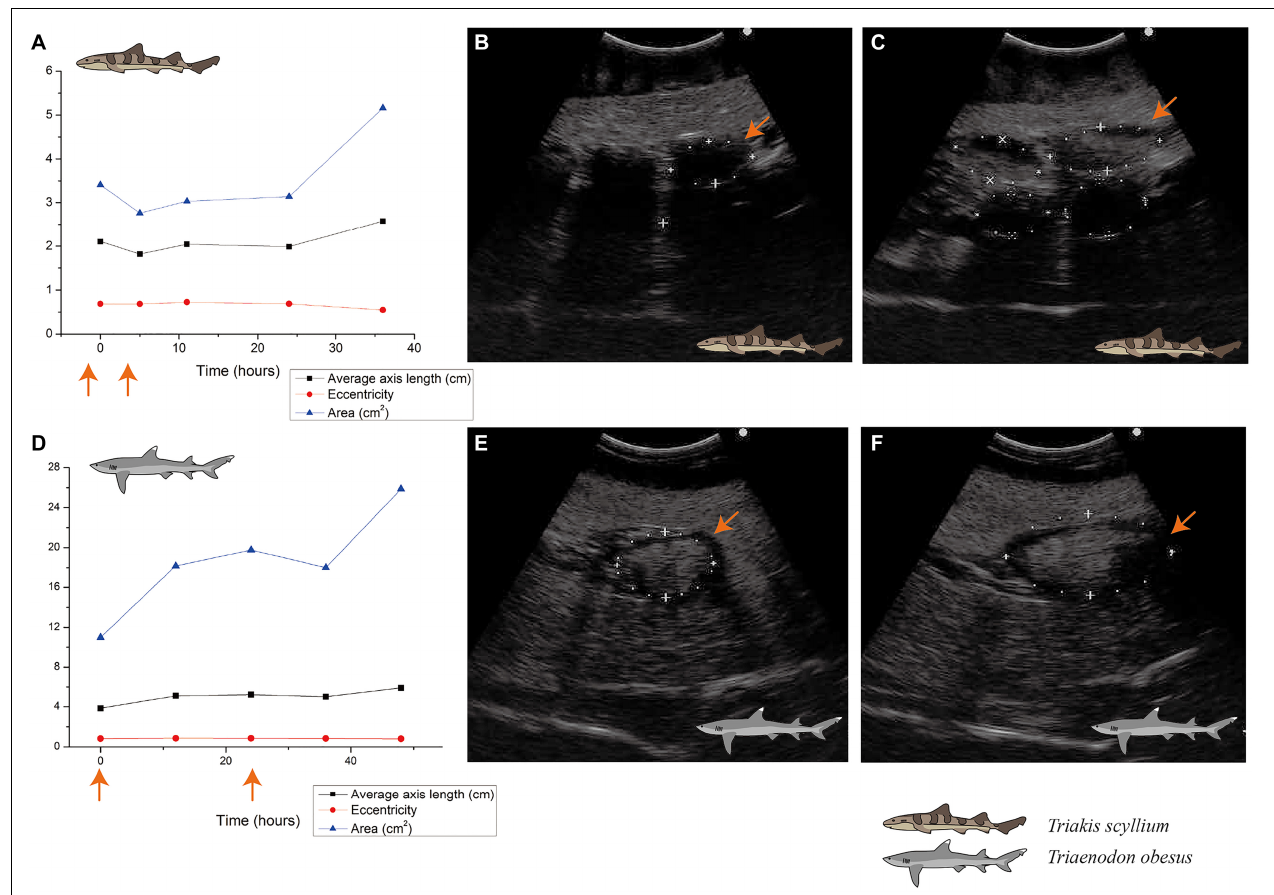
FIGURE 4 | Ovarian follicle size change after Ovaprim R (cid:13) injection in Triakis scyllium and Triaenodon obesus. (A) Ovarian follicle size changes after Ovaprim R (cid:13) injection in female T. scyllium . Axis length and area values were measured directly on ultrasonography. Eccentricity was calculated with the long and short axis values. The orange arrows indicate the time points of Ovaprim R (cid:13) administration. (B) Ultrasonography of left ovary before Ovaprim R (cid:13) injection in T. scyllium (F003). The orange arrows indicate the same follicle in (C) at different time point. Size of the follicle with the orange arrow was 3.7 cm × 1.9 cm (5.45 cm 2 ). (C) Ultrasonography of left ovary after Ovaprim R (cid:13) injection in T. scyllium (F003). Follicles showed distinct size increase. The orange arrows indicate the same follicle in (B) at different time point. Size of the follicle with the orange arrow was 4.9 cm × 2.0 cm (7.60 cm 2 ). (D) Ovarian follicle size changes after Ovaprim R (cid:13) injection in female T. obesus . Axis length and area values were measured directly on ultrasonography. Eccentricity was calculated with the long and short axis values. The orange arrows indicate the time points of Ovaprim R (cid:13) injection. (E) Ultrasonography of left ovary before Ovaprim R (cid:13) injection in WF002 ( T. obesus ). The orange arrows indicate the same follicle in (F) at different time point. Size change of the follicles can be recognized by ultrasonography. Size of the follicle with the orange arrow was 4.4 cm × 3.0 cm (10.27 cm 2 ). (F) Ultrasonography of left ovary after Ovaprim R (cid:13) injection in WF002 ( T. obesus ). The orange arrows indicate the same follicle in (E) at different time point. Size of the follicle with the orange arrow was 7.4 cm × 3.7 cm (21.77 cm 2